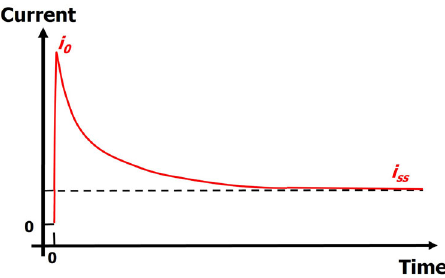
Fig. 2 Bruce-Vincent Method of measuring ion transference number from steady state in DC polarization curve. The equation only holds true under very stringent constraints: ideal electrolyte, absence of convection, and small DC